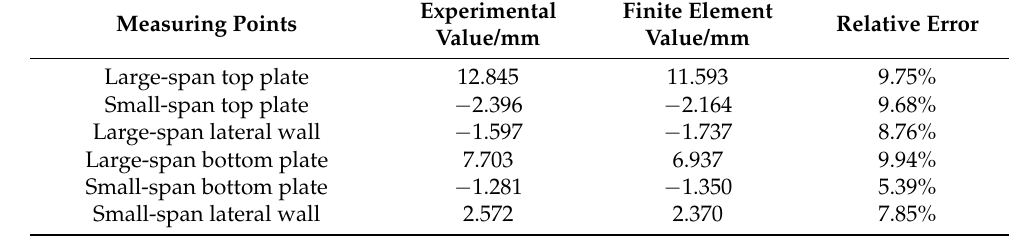
Table 5. Midspan deflection value.